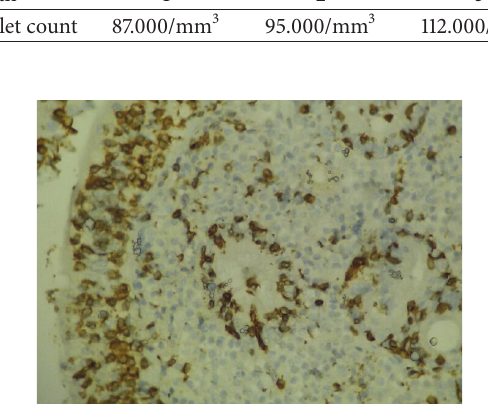
Figure 1: Total villous atrophy, increased number of intraepithelial lymphocytes, and crypt hyperplasia; CD3 × 400.